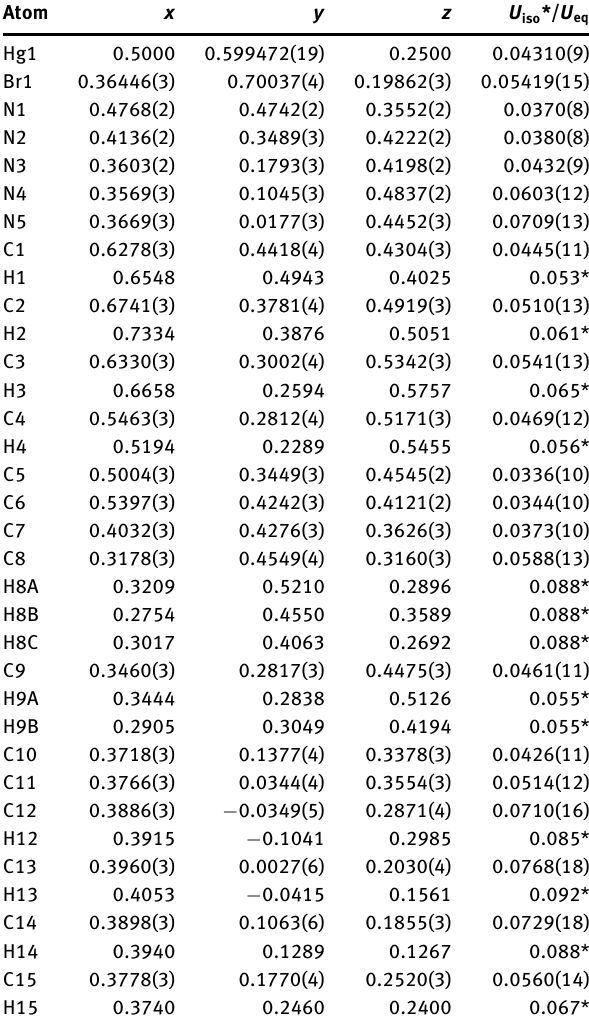
Table 2: Fractional atomic coordinates and isotropic or equivalent isotropic displacement parameters (Å 2